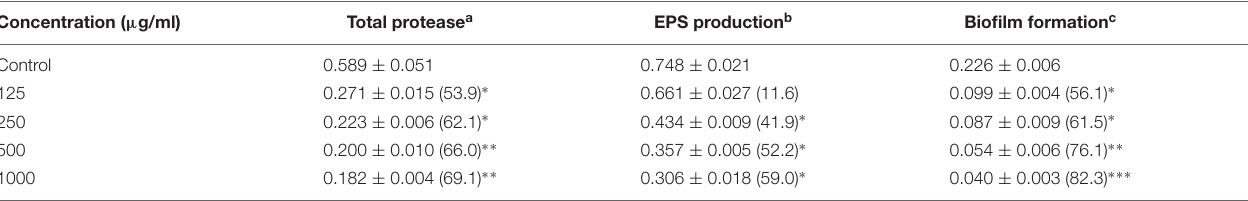
FIGURE 3 | Inhibition of swarming motility in P. aeruginosa PAO1 by sub-MICs of methanol extract of M. indica (leaf), (A) Untreated control; (B) 200 µ g/ml; (C) 400 µ g/ml; (D) 800 µ g/ml. TABLE 3 | Effect of Mangifera indica leaf extract on inhibition of QS regulated virulence factors in Aeromonas hydrophila WAF-38. Concentration ( µ g/ml) Total protease a EPS production